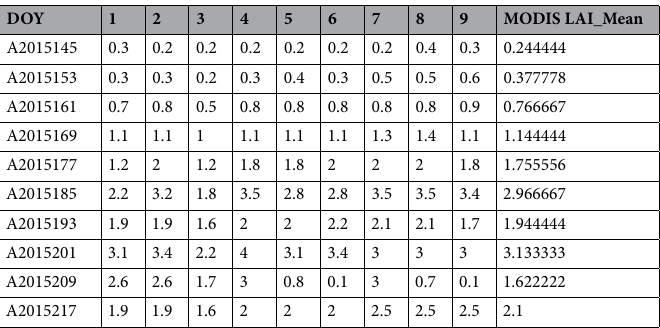
Table 2. MODIS leaf area index of 3 * 3 pixels around Huailai experimental